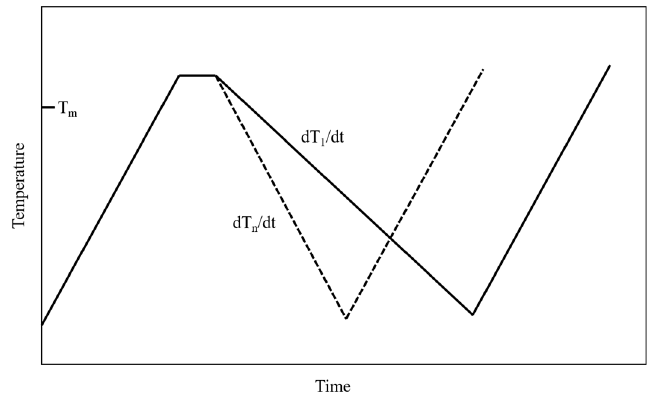
Figure 1. Schematic diagram of the temperature profiles used in the non-isothermal crystallisation DSC analysis. dT i /dt represents the cooling rate during the experiments.